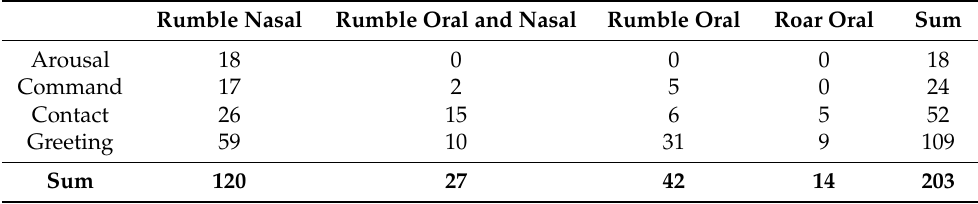
Figure 3. Example of a roar–rumble combination. Emitted during the separation phase of a separation– reunion experiment by Hira (f, 45y). This shows acoustic camera images of different time and frequency ranges ( a – f ) and the corresponding spectrogram, with a zoom–in on the rumble part ( e , f ) and the power spectrum ( a , b ) taken in the middle of the roar between selection window a and b. The LPC function line in red indicates the formant positions (F1–F9); ( a , b , d ) show the oral only emission of the roar parts; ( c ) shows the partial oral emission of the mixed emission rumble part, exhibiting a distorted sphere and the ( e ) nasal emission of the lower harmonics; ( f ) shows a pattern of simultaneous sound radiation over the front, the mouth and trunk, as well as a strong ground reflection here at the transition between roar and rumble. Table 3. Behavioral context. Number of call types combined with call emission per behavioral